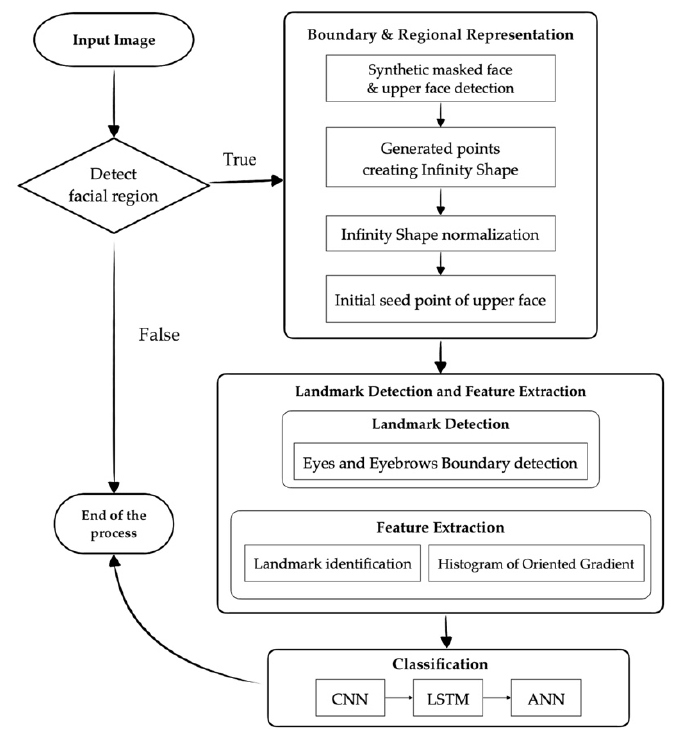
Figure 8. Illustration of the proposed method and the algorithm.